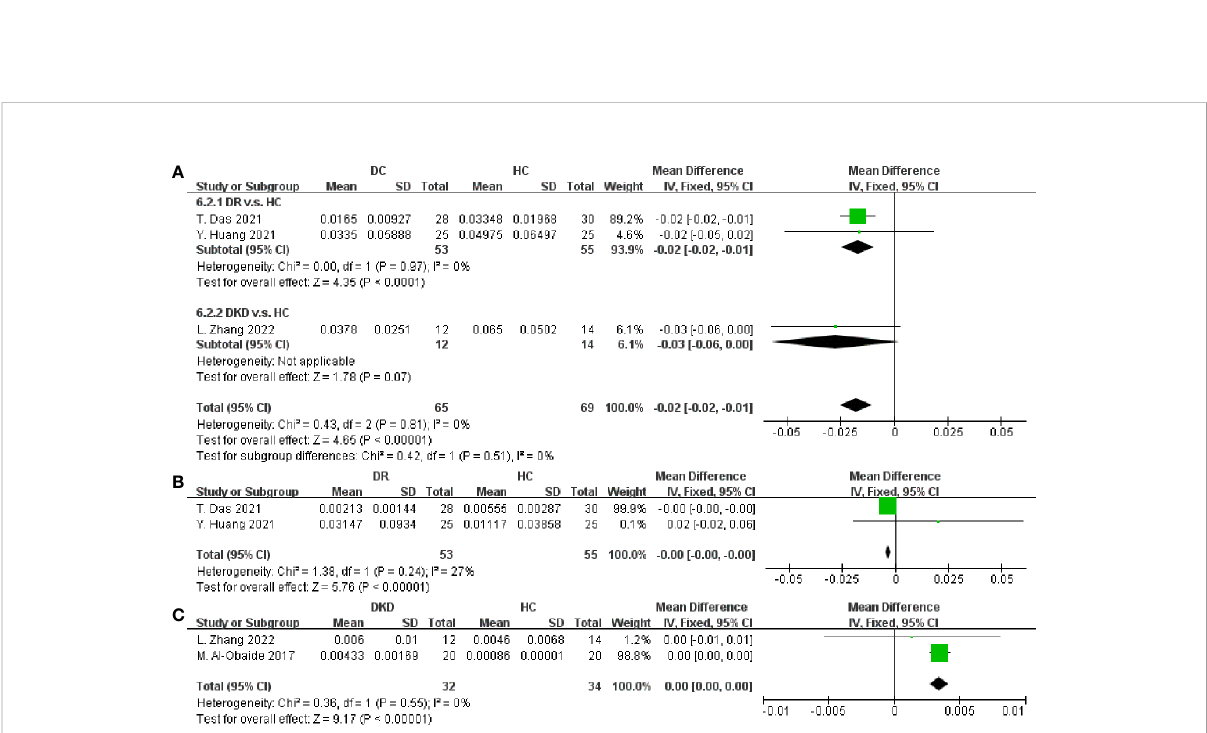
FIGURE 7 Forest plots of microbiota at the genus level in DC v.s. HC. (A) Faecalibacterium ; (B) Lactobacillus ; (C) Klebsiella